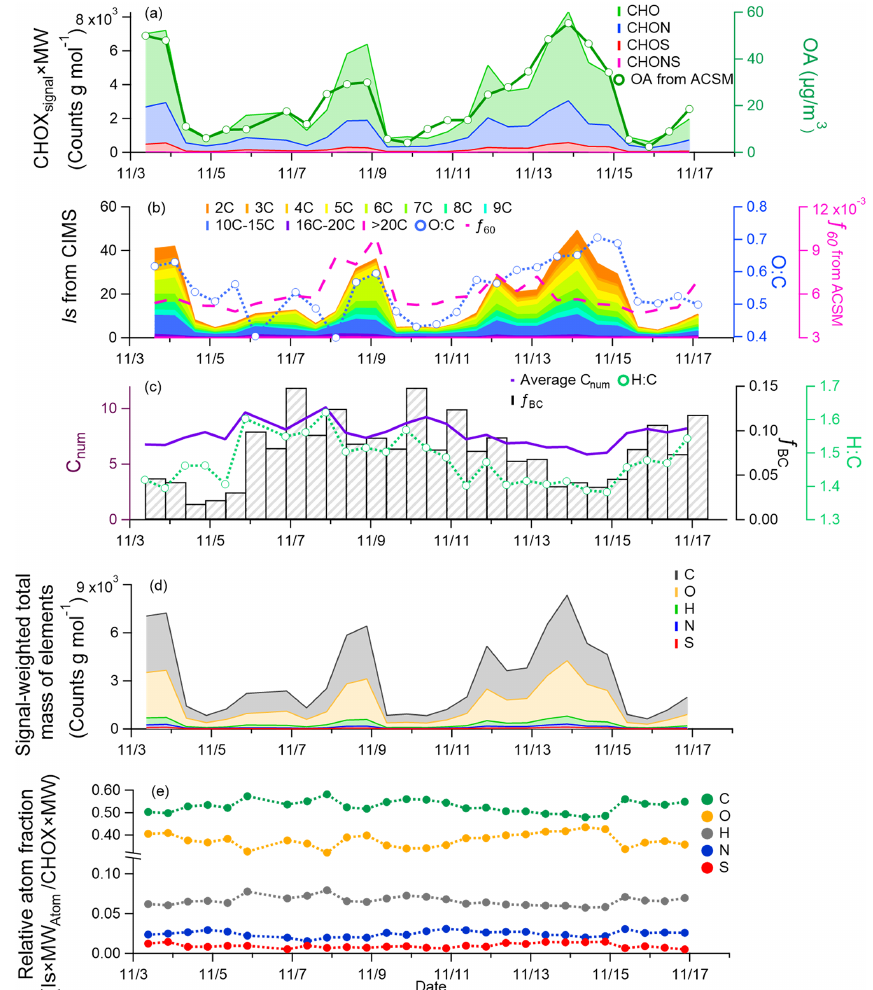
Figure 2. Time series of the (a) abundance of CHO, CHON, CHOS, and CHONS compounds and OA concentrations measured by the ToF- ACSM; (b) signals of compounds grouped according to carbon number and O / C ratio; (c) average carbon number, H / C ratio, the fraction of BC to NR-PM 2 . 5 + BC, and f 60 from the ToF-ACSM; (d) signal-weighted total mass of elements C, O, H, N, and S; and (e) relative atom fraction of C, O, H, N, and S. The date is given in the format